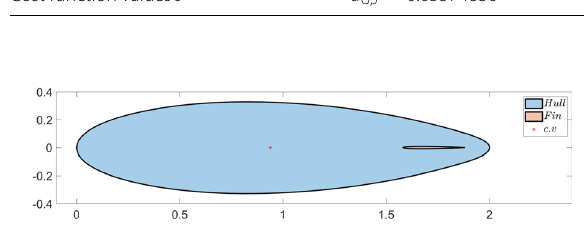
Fig. 25 Schematic diagram of optimized